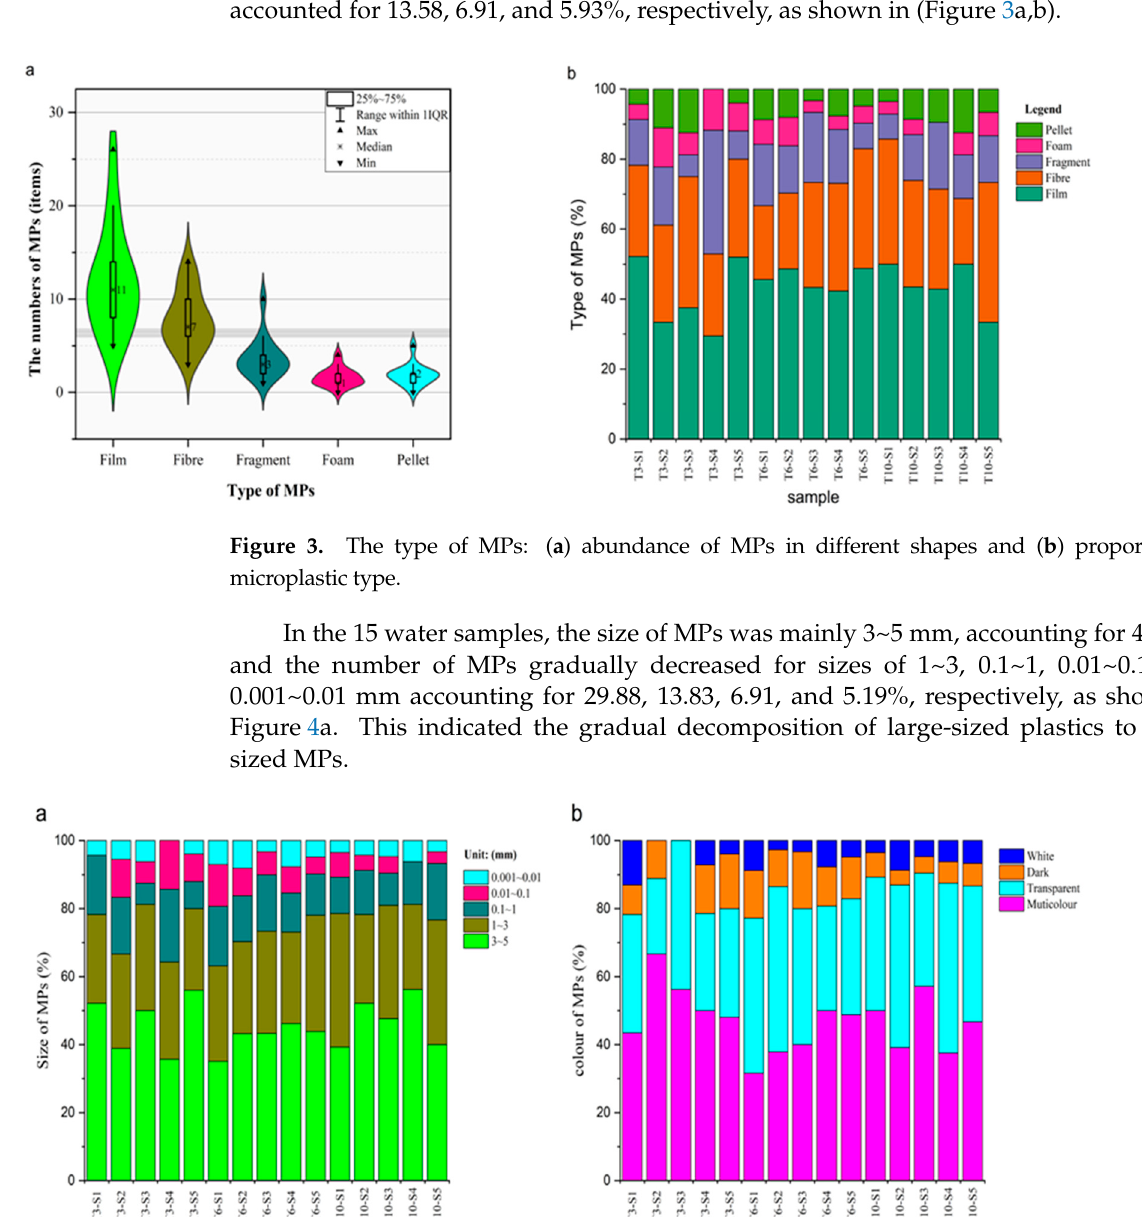
Figure 4. The proportion of size and color of MPs: ( a ) size and ( b ) color. The karst groundwater samples contained MPs in four color categories, namely, trans- parent, white, black, and colored (predominantly red, blue, brown, and yellow). Colored MPs accounted for the highest proportion, with 44.94%, followed by transparent MPs, ac- counting for 39.01%, and black and white MPs accounting for 10.37 and 5.68%, respectively, as shown in (Figure